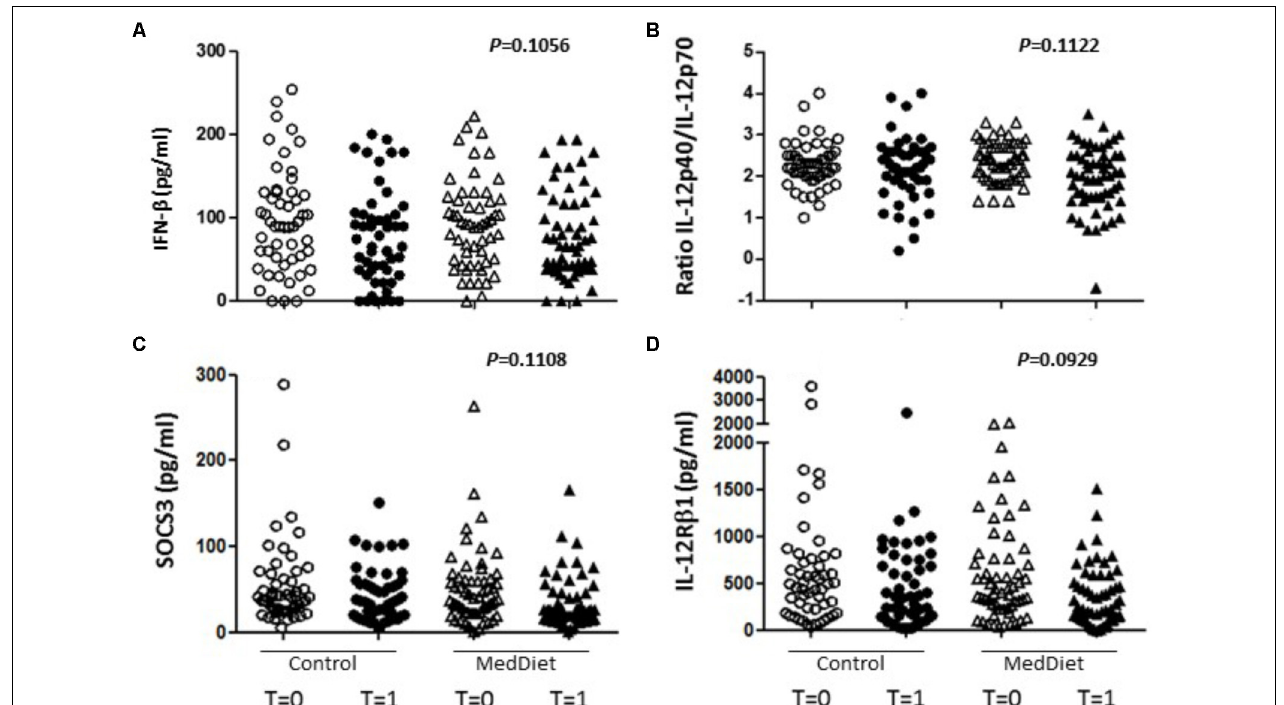
FIGURE 3 | Effects of the MedDiet on cytokine expression following in vitro challenge with TLR agonists-all individual values. PBMC were cultured with a cocktail of TLRs agonists (PolyA:U, Imiquimod, ODN-M362, LPS, Pam2CSK4) for 22 h. Levels of cytokines were determined in culture supernatants. Representation of the individual values for IFN- β (A) , IL-12p40/70 ratio (B) , SOCS3 (C) and IL-12R β 1 (D) concentration in all the volunteers at baseline and after 1 year of intervention. Results showed a tendency toward increased production of IFN- β (OR 1.98, 95%CI 0.86–4.53, P = 0.1056), and decreased production of IL-12R β 1 (OR 0.50, 95%CI 0.22–1.13, P = 0.0929), SOCS3 (OR 0.50, 95%CI 0.21–1.18, P = 0.1108) and the ratio between IL-12p40/IL-12p70 (OR 0.54, 95%CI 0.26–1.16, P = 0.1122. OR = odds ratio), CI, confidence